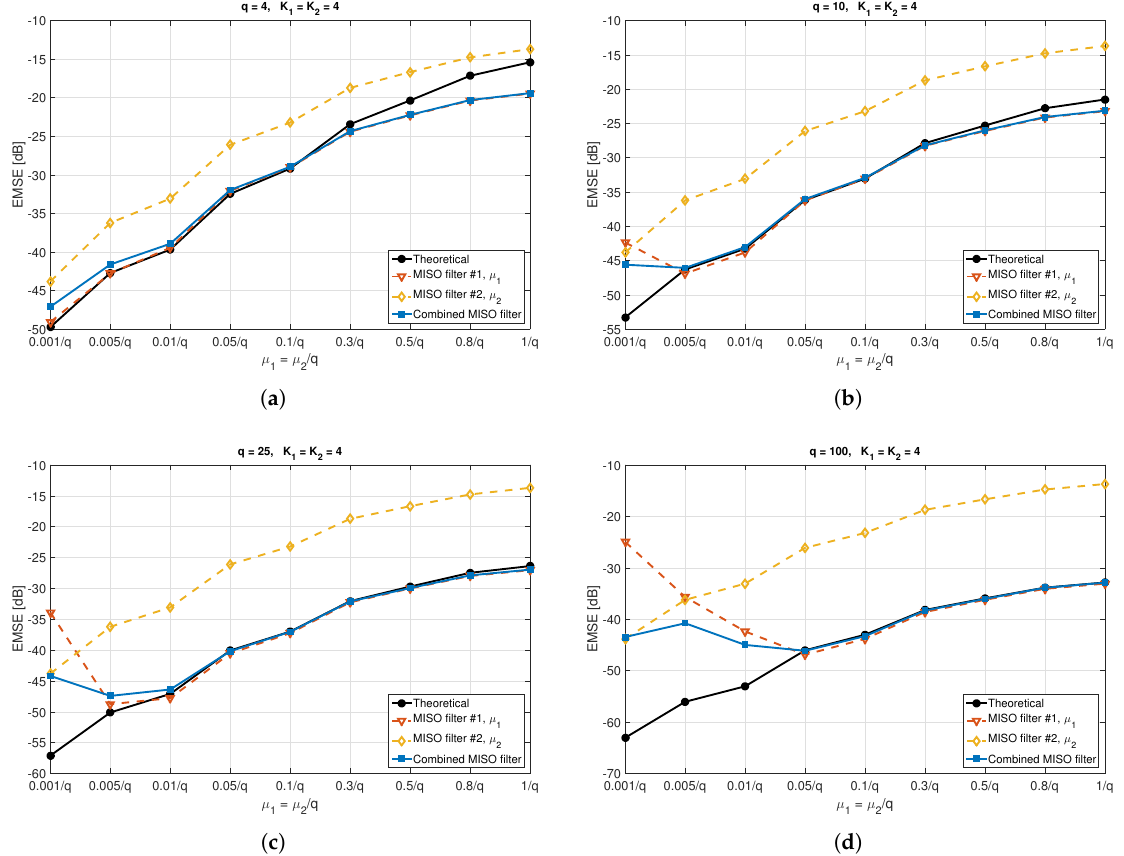
Figure 2. Steady-state theoretical and measured excess mean squared error (EMSE) for a combined MISO filter using different step-size values, according to µ 1 = µ 2 / q , with ( a ) q = 4, ( b ) q = 10, ( c ) q = 25, and ( d ) q =